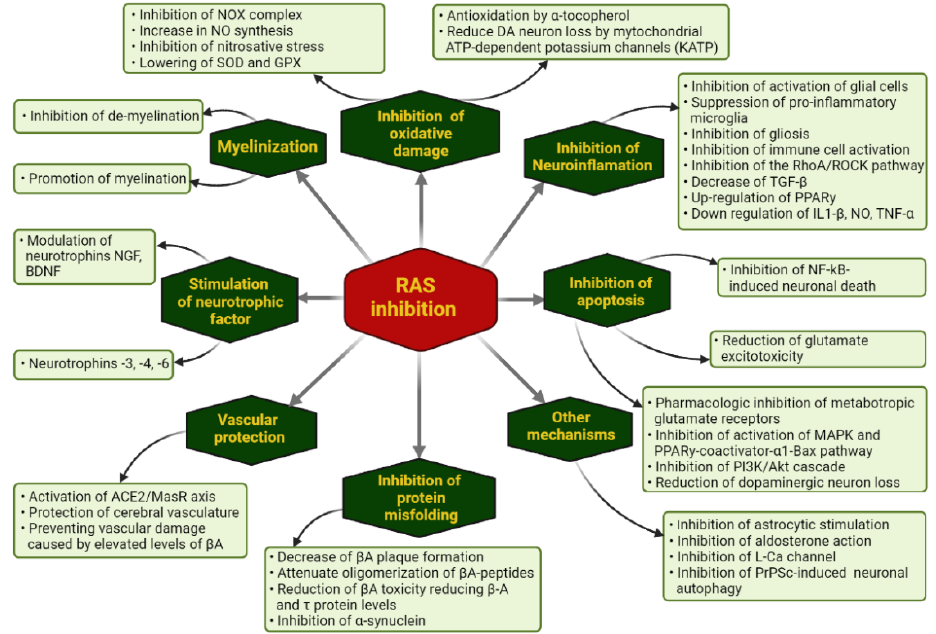
Figure 1. Ways through which pharmacological RAS inhibition may modulate the evolution of NDG